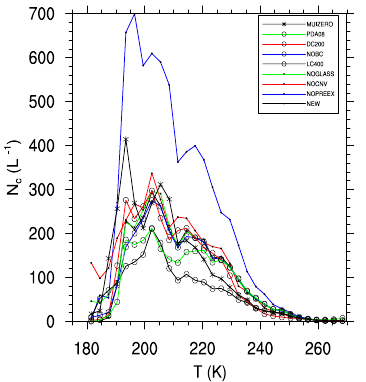
Figure 16. Annual mean ice crystal concentration as a function of temperature for the different runs of Table